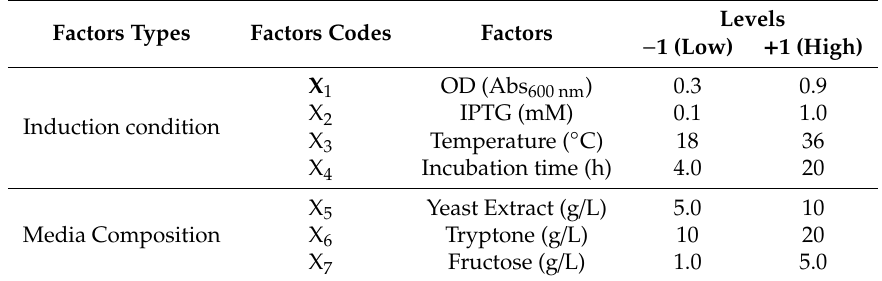
Table 1. The minimum and maximum ranges for di ff erent factors studied during screening process.